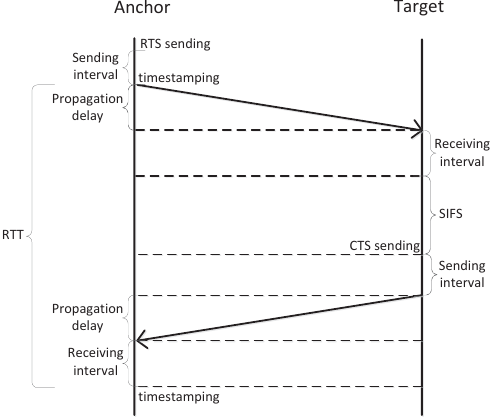
Figure 3: RTT detailed Structures